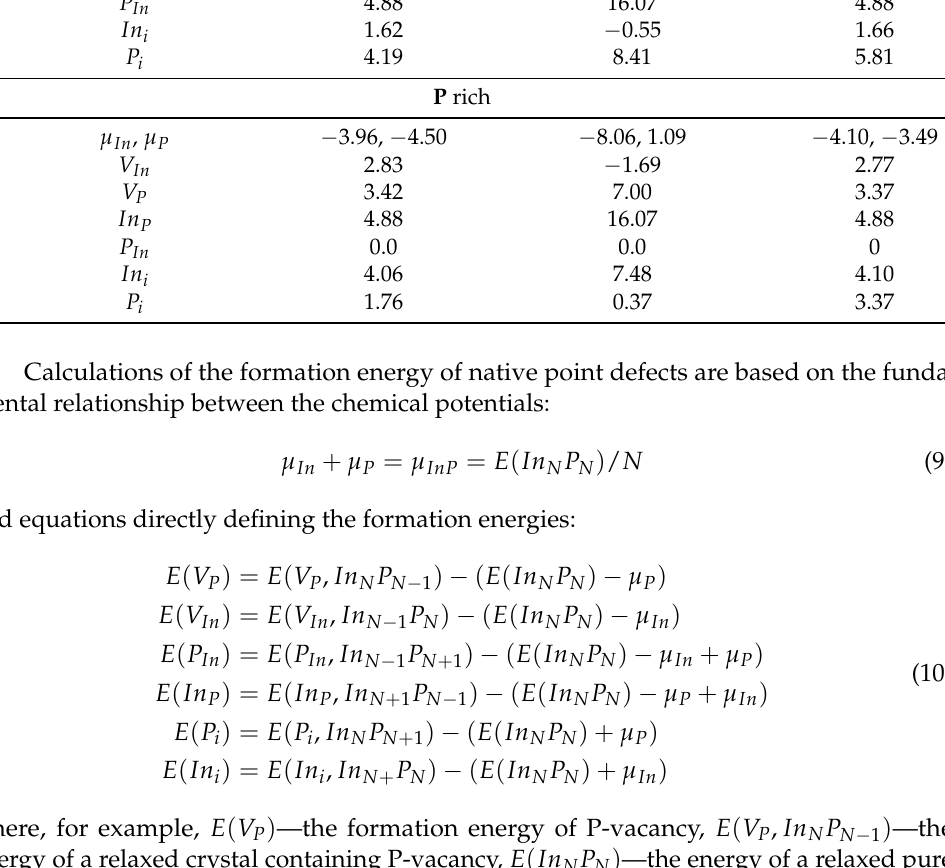
Table 2. The formation energy E f (eV) of native point defects in B3 phase of the InP crystal. B3 Native Point Defects, E f Mishra (DFT) Branicio This Work In rich µ In , µ